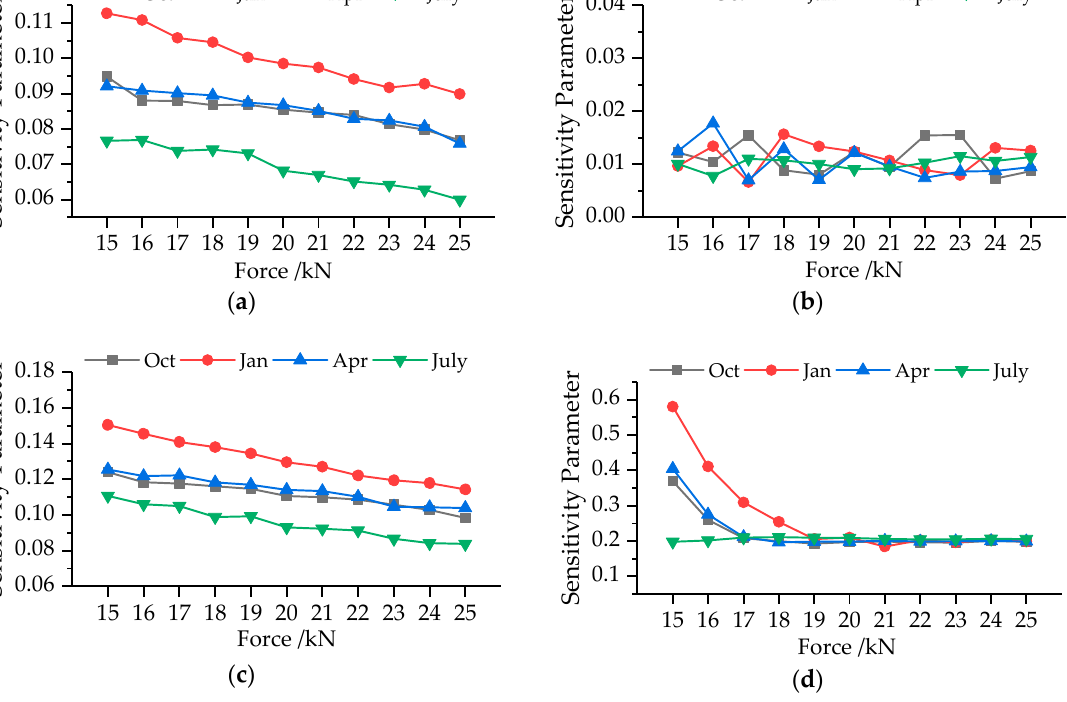
Figure 16. SP for the influence factors with external force variation: ( a ) temperature; ( b ) humidity; ( c ) modal frequency; ( d ) MS. ( c ) modal frequency; ( d )